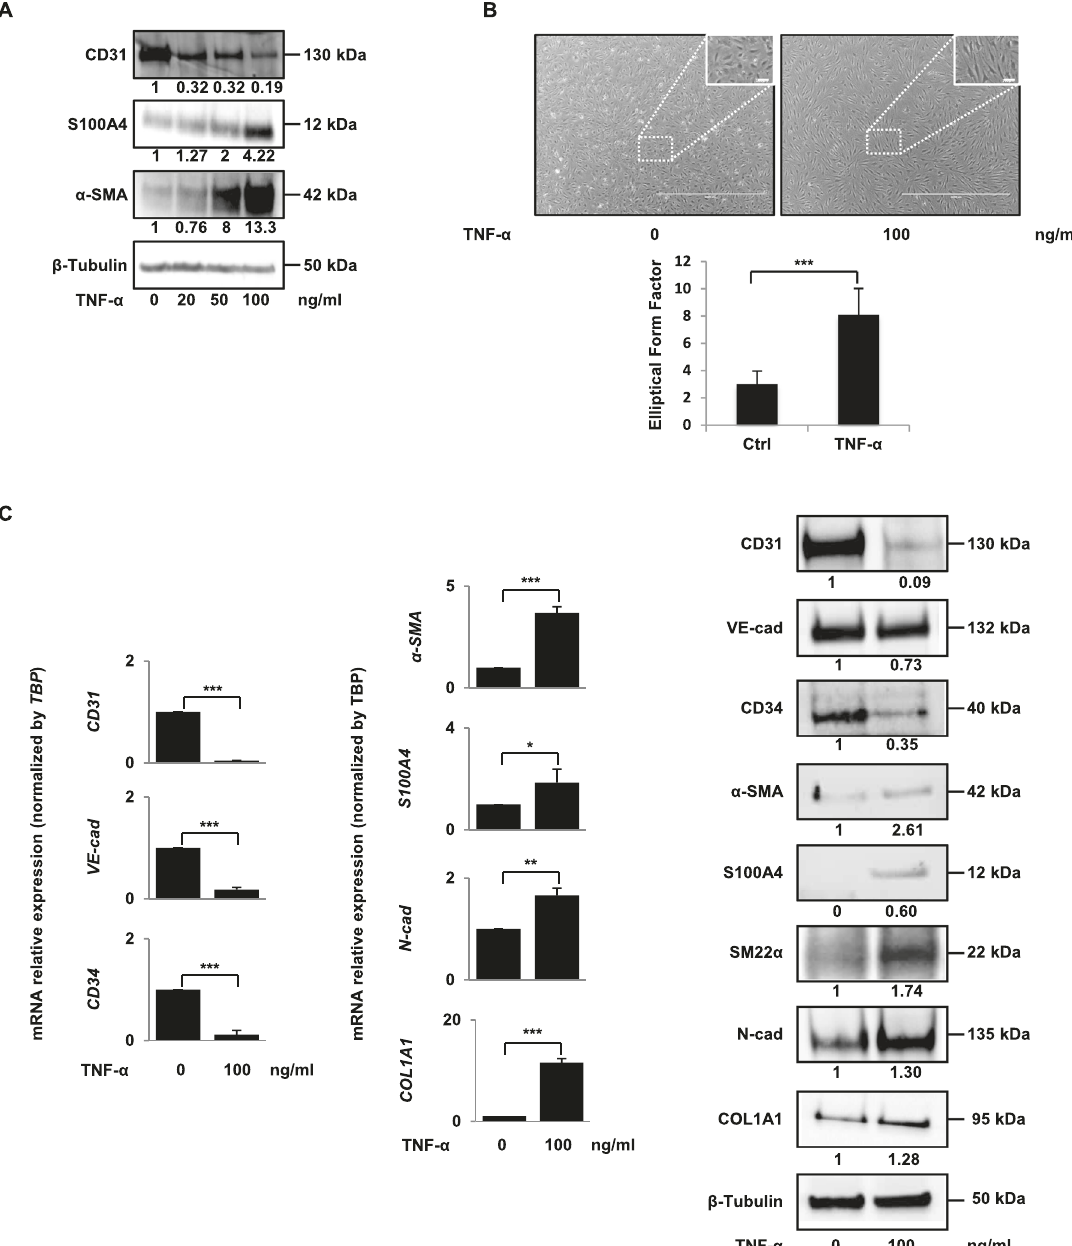
Fig. 1 TNF- α induces endothelial – mesenchymal transition. A TNF- α decreases the protein expression of vascular endothelial marker (CD31) and increases the protein expression of mesenchymal markers (S100A4, α -SMA). HMVECs were treated for 96 h with 0, 20, 50 or 100 ng/ml of TNF- α . Protein expressions were analysed by western blot. B Morphological changes induced by a 100 ng/ml TNF- α treatment (photographs). The histogram shows ImageJ software analysis of cell morphology by calculating the elliptical form factor EFF (the major axis divided by minor axis). Results are the average of 100 cells. C TNF- α decreases the mRNA (left panel) and protein (right panel) expression of vascular endothelial markers (CD31, CD34, VE-cadherin) and increases the mRNA (left panel) and protein (right panel) expression of mesenchymal markers (COL1A1, N-cadherin, S100A4, α -SMA, SM22- α ). mRNA levels were quanti fi ed by RT-qPCR. TBP for RT-qPCR and β -tubulin for western blot analysis were used as controls. RT-qPCR histograms show the mean of three independent biological experiments and western blots are representative of three independent biological experiments. Signi fi cant differences are indicated by solid lines (* P < 0.1, ** P < 0.05, *** P < 0.005 by t test). Scale bars, 100 µm (inset) or 2000 µm. HMVEC human microvascular endothelial cell, TNF- α tumour necrosis factor- α , α -SMA α - smooth muscle actin, VE-cad VE-cadherin, COL1A1 collagen type I α 1, N-Cad N-cadherin, Ctrl control, mRNA messenger RNA, TBP TATA-box binding Various incubation times were then tested (Supplemental Fig. 1C), showing that the downregulation of CD31 began at 24 h, the (Fig. 1C). Furthermore, FACS analysis demonstrates that the TNF- α - upregulation of α -SMA began at 48 h and that these effects were induced decrease of CD31 protein expression affects a large maintained up to at least 168 h. majority of endothelial cells (Supplemental Fig. 1B).